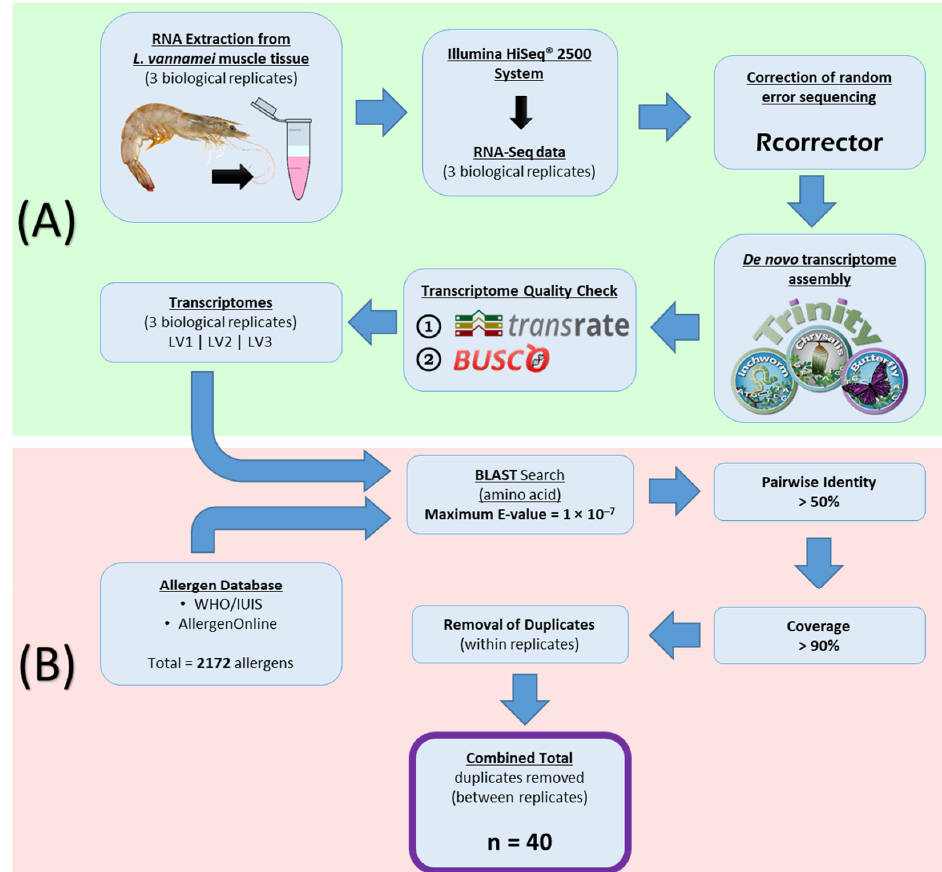
Figure 1. Schematic representation of ( A ) de novo transcriptome assembly and ( B ) transcriptomic analysis used in the identification of allergens in shrimps. The example shown here is for L. vannamei . LV1, LV2, and LV3 represent the three biological replicates of L. vannamei samples. ‘n’ equals the number of allergens identified in L. vannamei . A total of 40 allergens were identified.